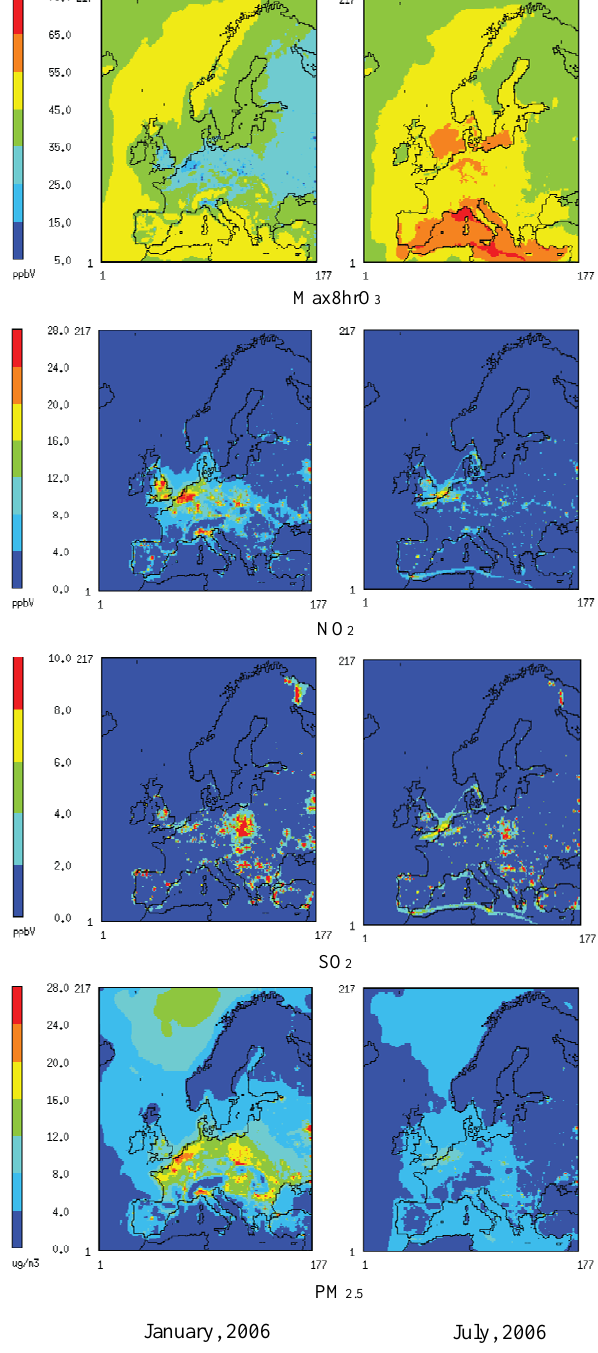
Fig. 2. Simulated daily (Max8hO 3 , PM 2 . 5 ) and hourly (NO 2 , SO 2 ) average concentrations for January (left column) and July (right col- umn)